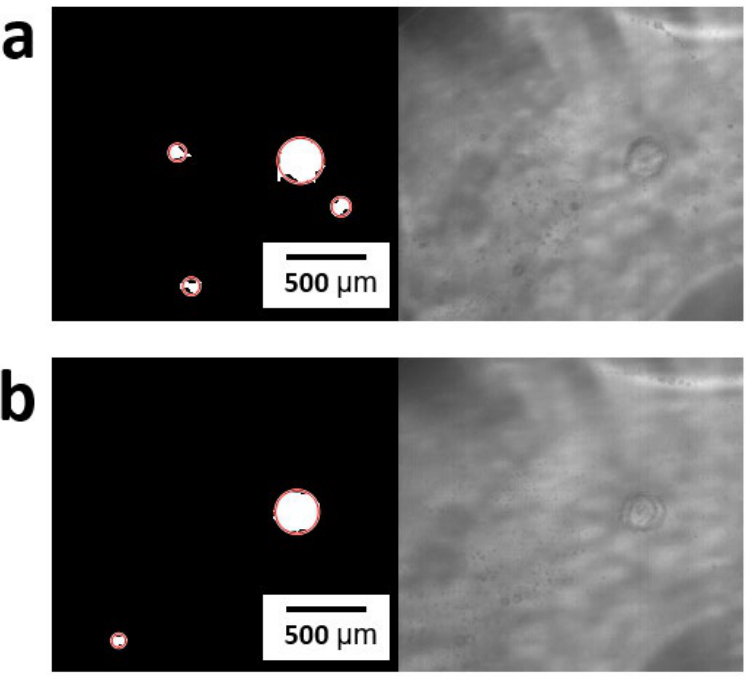
Figure 12. Images showing the morphologically constructed inclusion and the corresponding HTSC microscopy images showing a blurry silica inclusion recorded at ( a ) 1577.7 °C and at time 486.17 s and ( b ) 1579.6 °C and at time 487.36 s.